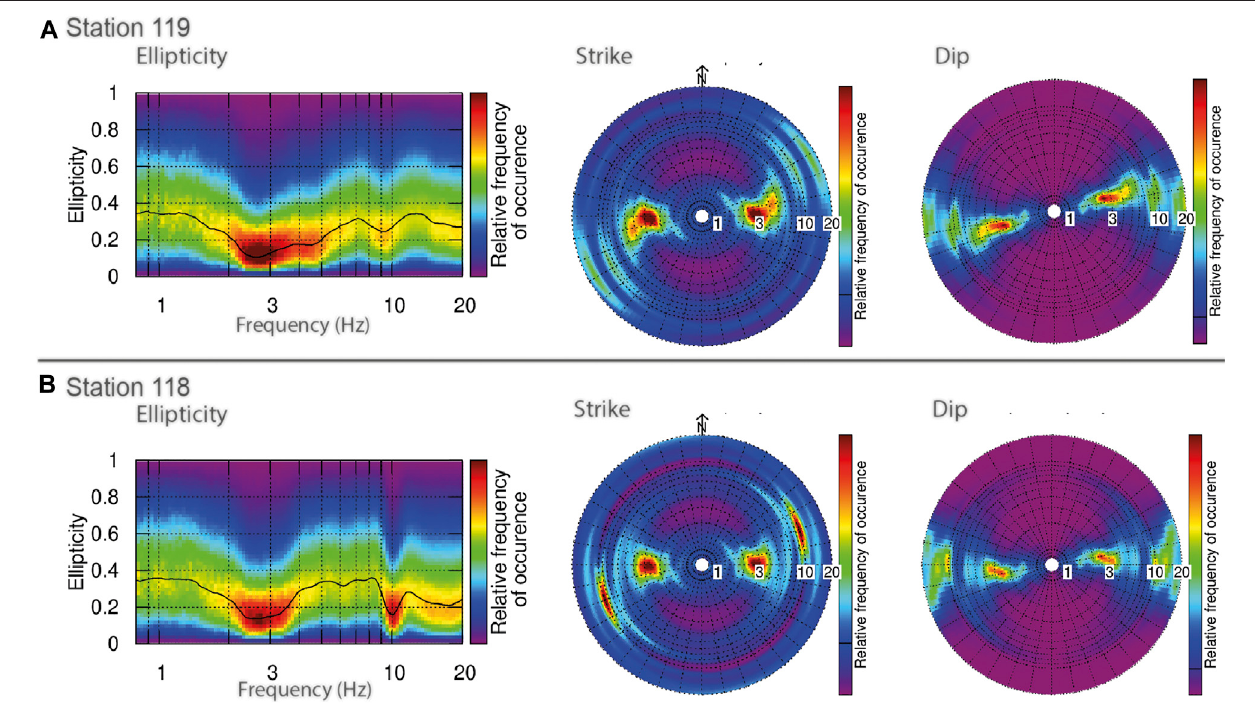
FIGURE 4 | Example of the seismic response of stations at Flue in terms of ground motion polarization; (A) Station 119 (located NW of the Flue ) with its ellipticity droppingaround3 Hz,thestrikeinE-Wdirectionanddiptiltedbyaround15 ° downwards; (B) Station118locatedinthecentralareaofthearrayon Flue withitsellipticity showing two drops at around 3 and 10 Hz, its strike in E-W direction for the peak at 3 Hz and NE-SW for the peak at 10 Hz and a horizontal dip.